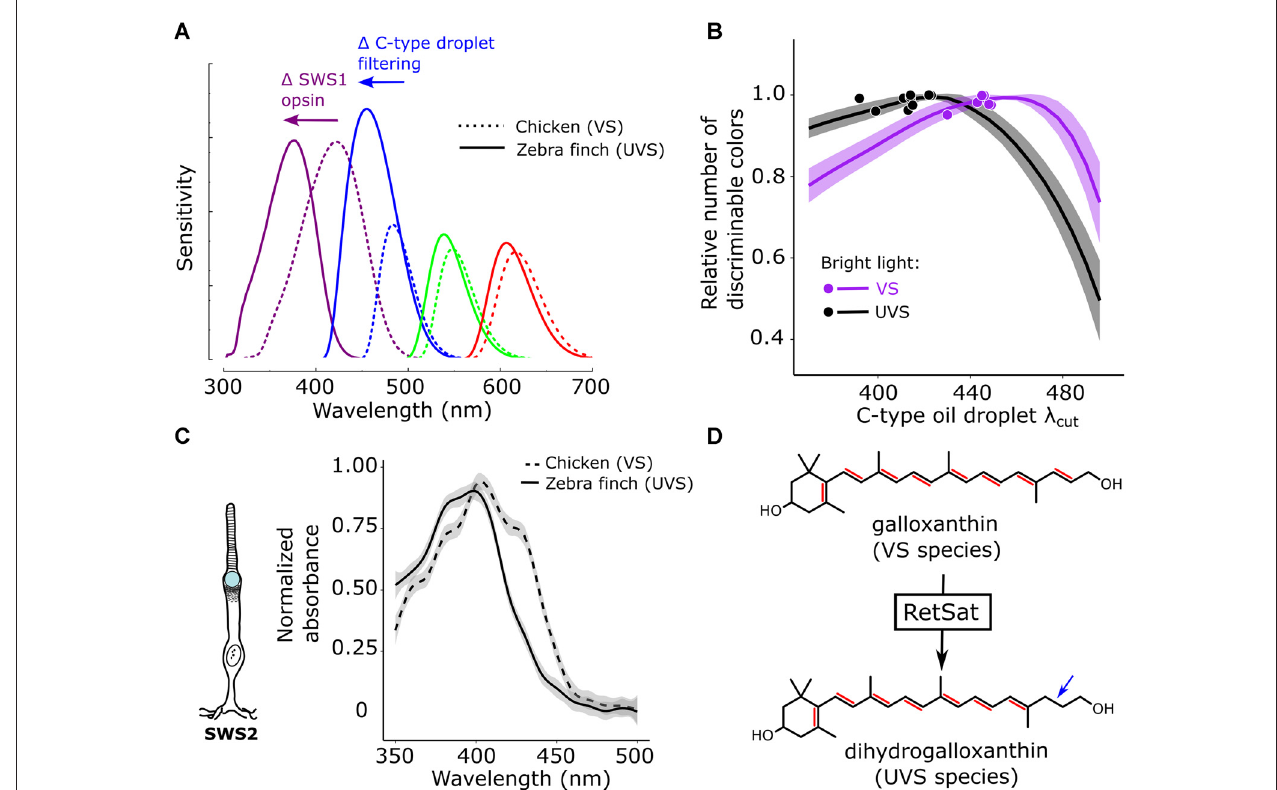
FIGURE 4 | Color discrimination is optimized via co-evolution of opsin and oil droplet spectral tuning. (A) Avian visual systems fall in two categories: those with an SWS1 opsin maximally sensitive to violet light (VS, e.g., chicken—dotted lines) and those maximally sensitive to ultraviolet light (UVS, e.g., zebra finch—solid lines). In UVS species, the SWS1 cone sensitivity is short-wavelength shifted, relative to VS species, as the result of amino acid substitutions in the SWS1 visual pigment opsin. In concert with this shift in the SWS1 cone, the sensitivity of the SWS2 cone is also short-wavelength shifted through a change in the carotenoid-based spectral filtering of the C-type oil droplet within the cone. (B) These complementary shifts in the sensitivity of the SWS1 and SWS2 cones serve to maintain even spacing of receptor sensitivities across the light spectrum, and computational models of avian color discrimination indicate that these shifts optimize the visual system for color discrimination. Here the receptor noise limited model was used to predict that maximum number of discriminable colors for seven VS species (purple) and 11 UVS species (black). All parameters of the visual system were held constant, while the spectral filtering of the C-type droplet ( λ cut ) was varied across a wide range and the number of discriminable colors was determined at each λ cut value. The lines represent the mean ± SD model predictions for each visual system and the points represent the actual C-type droplet ( λ cut ) for each of the 18 species modeled. Note how relatively long-wavelength shifted C-type filtering maximizes the number of discriminable colors for VS species, relatively short-wavelength shifted filtering maximizes the number of discriminable colors for UVS species, and the measured filtering falls close to the model optima for each visual system. These shifts in spectral filtering of the C-type droplet (C) between VS and UVS species result from a change in dominant pigment within the C-type droplet from galloxanthin to dihydrogalloxanthin. (D) The enzyme retinol saturase (RETSAT) has been implicated in this conversion. This figure has been adapted from Toomey et al. (2016).